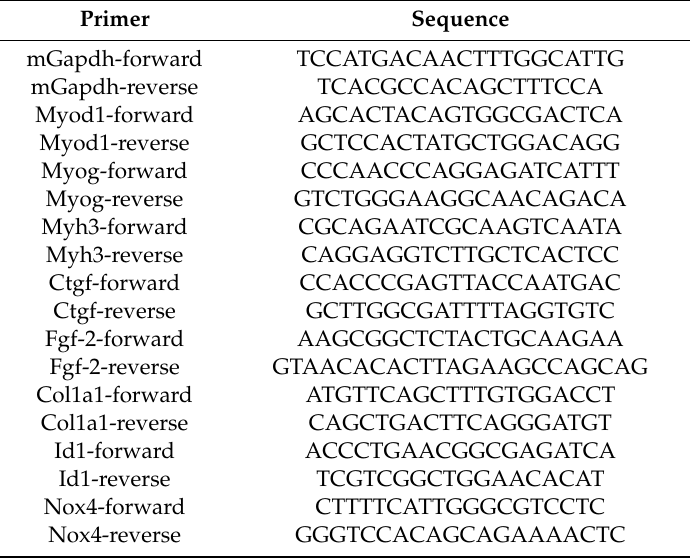
Table 1. Primers for